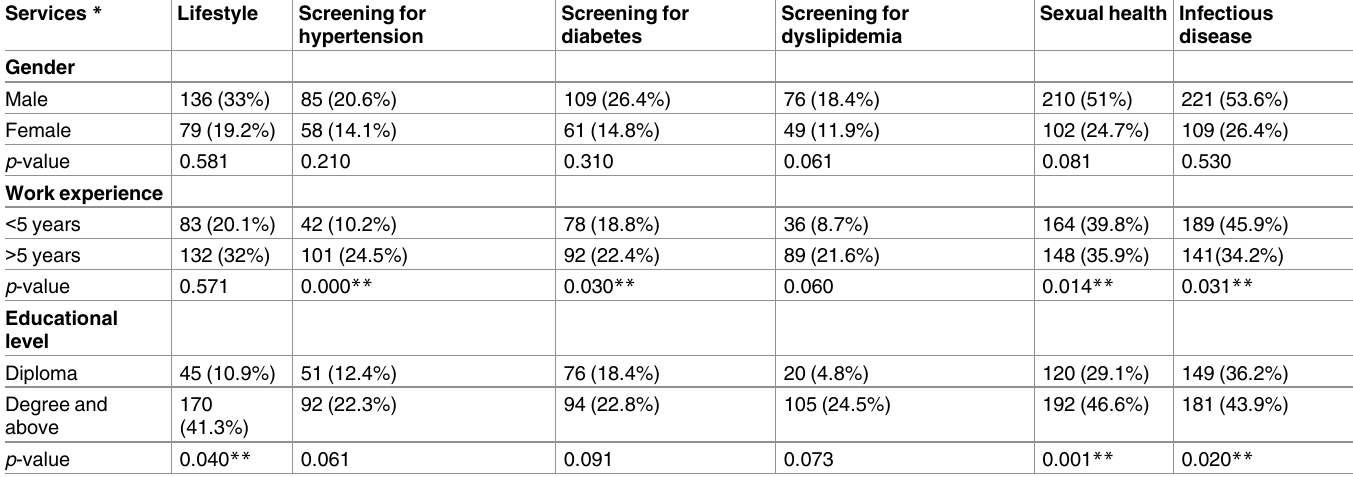
Table 4. Statistical test (chi square) of the involvement of community pharmacyprofessionals in selected public health priorities according to demographic variables,Amhara, Ethiopia (N = 412). Services *